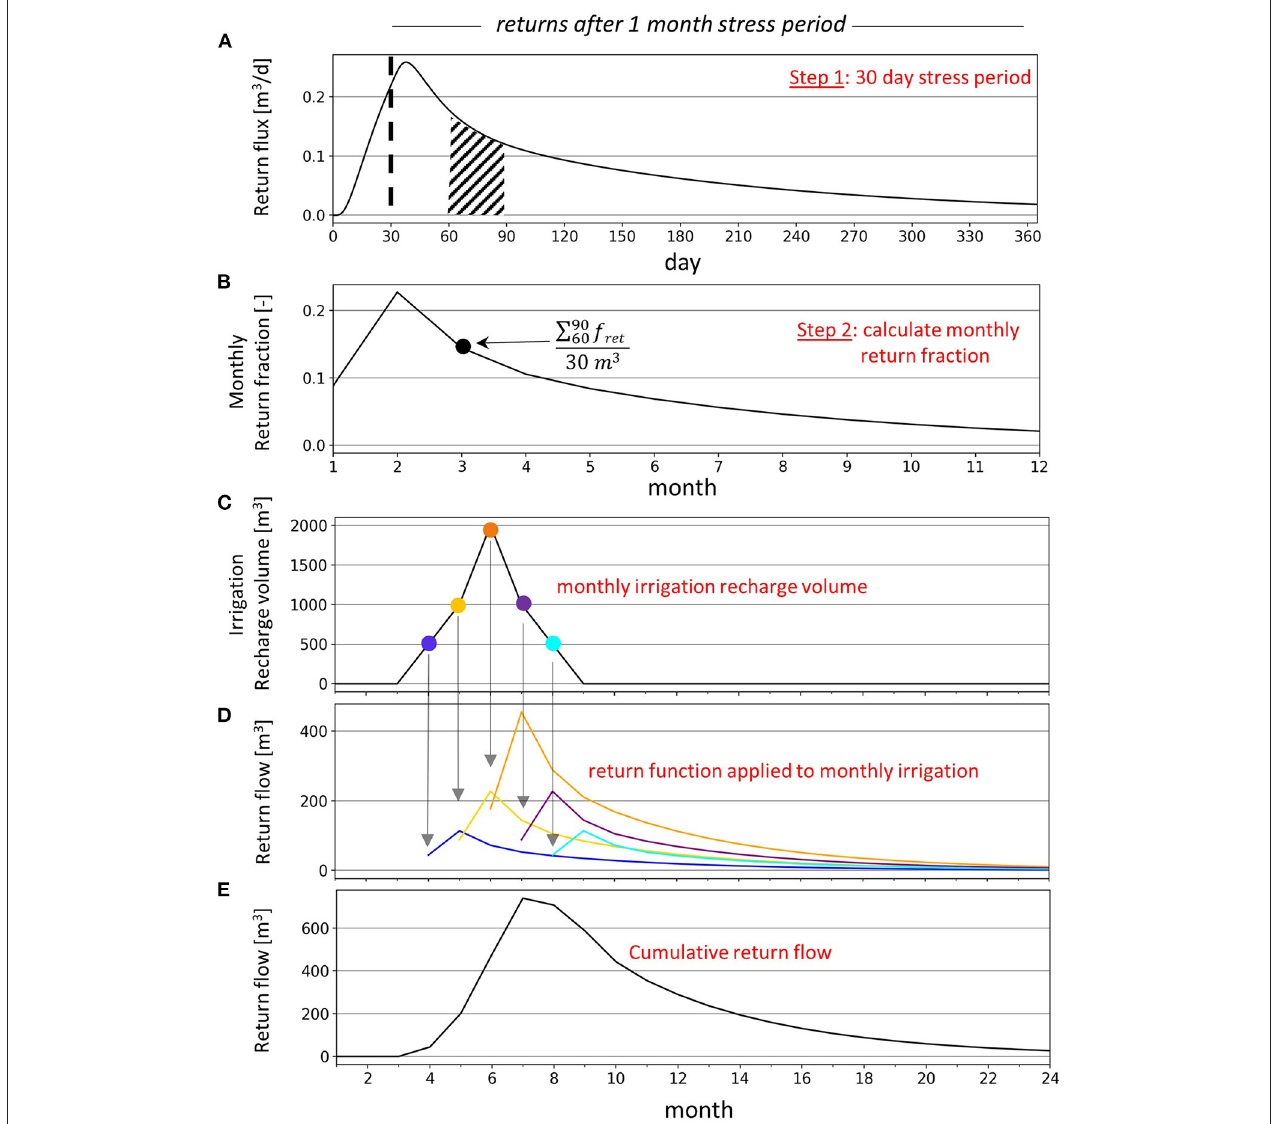
FIGURE 3 | Example of the analytical return flow methodology. The first step is to create the daily return flow fraction for a 30-day stress period (A) . The end of the stress period is denoted by the dashed line. The daily return fraction is then integrated in 30-day intervals (ex. hash marked region in subplot a) and divided by 30 m 3 (30 days of unit recharge) to generate the monthly return flow fraction (B) . The monthly return fraction is then used to generate the lagged returns for each month of a irrigation recharge time series (C,D) . The individual return flow time series for each month of recharge can then be summed to produce the cumulative return flow time series (E)